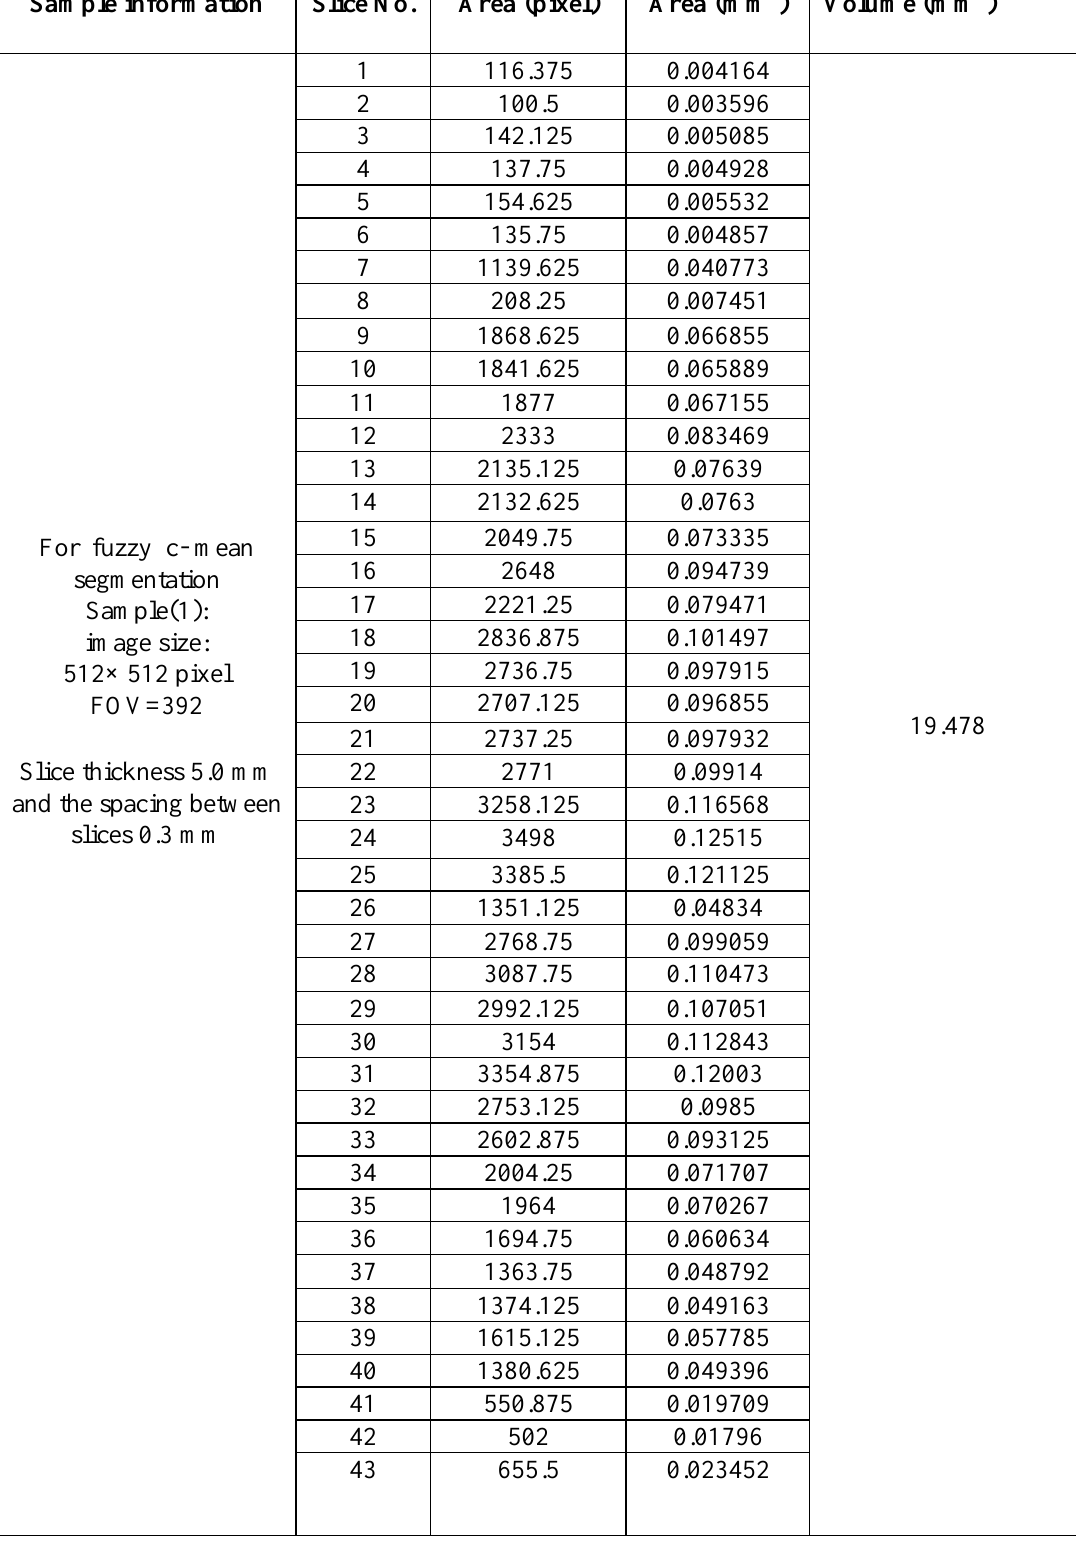
Table 1: The area and volume tumor using Fuzzy C- mean